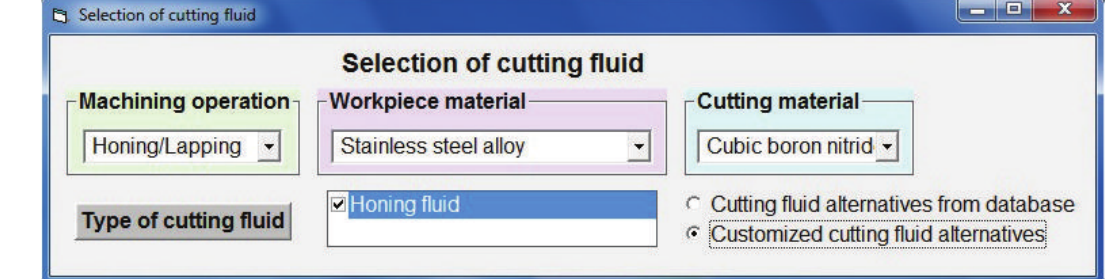
Figure 6: Opening window for Example 2.